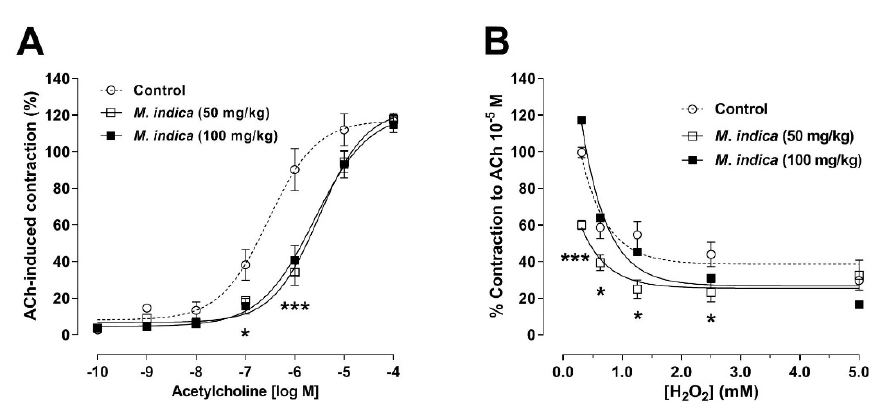
Figure 6. Chronic administration of lyophilized extract of M. indica (MIE) reduced contractile response to acetylcholine ( A ) and H 2 O 2 ( B ). Treatment for 28 days with MIE 50 mg/kg ( □ ) and 100 mg/kg ( ) reduces the contractile response to ACh. Contractile response to ACh or H 2 O 2 of the ileal segments of rats treated with peanut butter (vehicle) served as a control ( ). Each point represents the mean of maximal response in percentage ± SEM of five experiments ( n = 5). * p < 0.05; *** p < 0.001 vs. control.